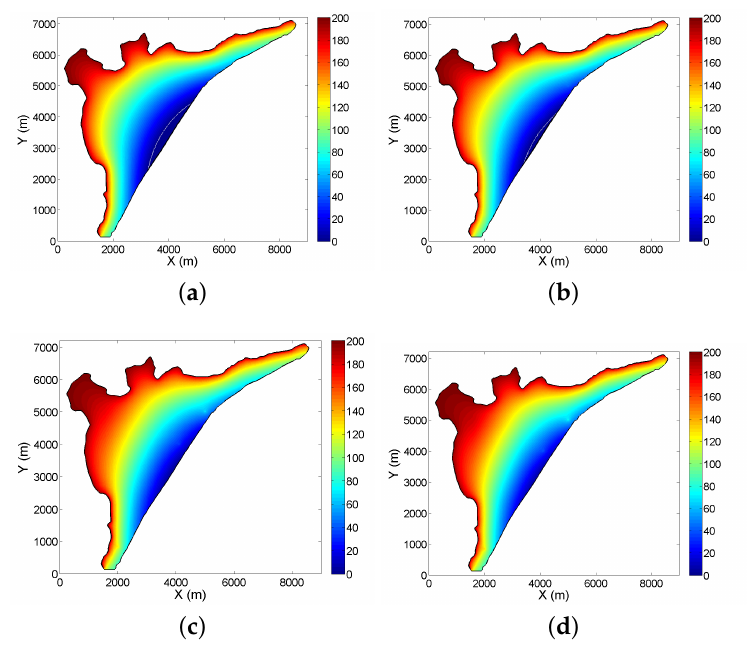
Figure 10. Position of the saltwater/freshwater interface g in different scenarios; ( a ) No-pumping “NOP”; ( b ) Recommendation of 120 L/capita/day “REC”; ( c ) After 10 years with 250 L/capita/day “10 Y”; ( d ) After 20 years with 250 L/capita/day “20 Y”.